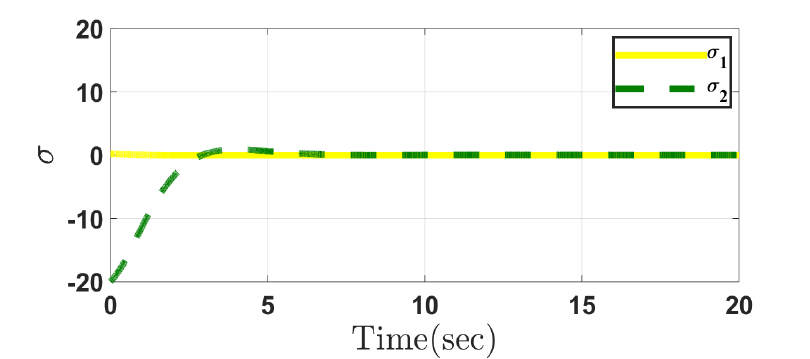
Figure 6. Sliding mode surfaces in the proposed method in Case 1.